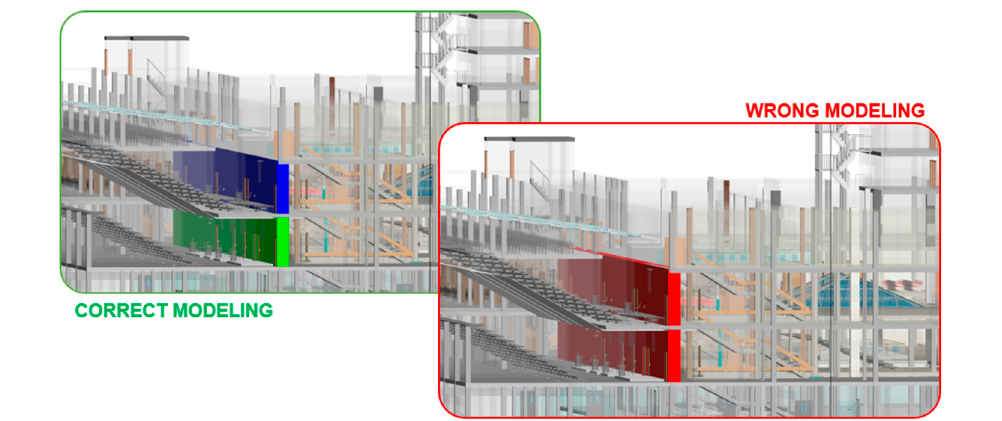
Figure 4. Corridor rehabilitation.